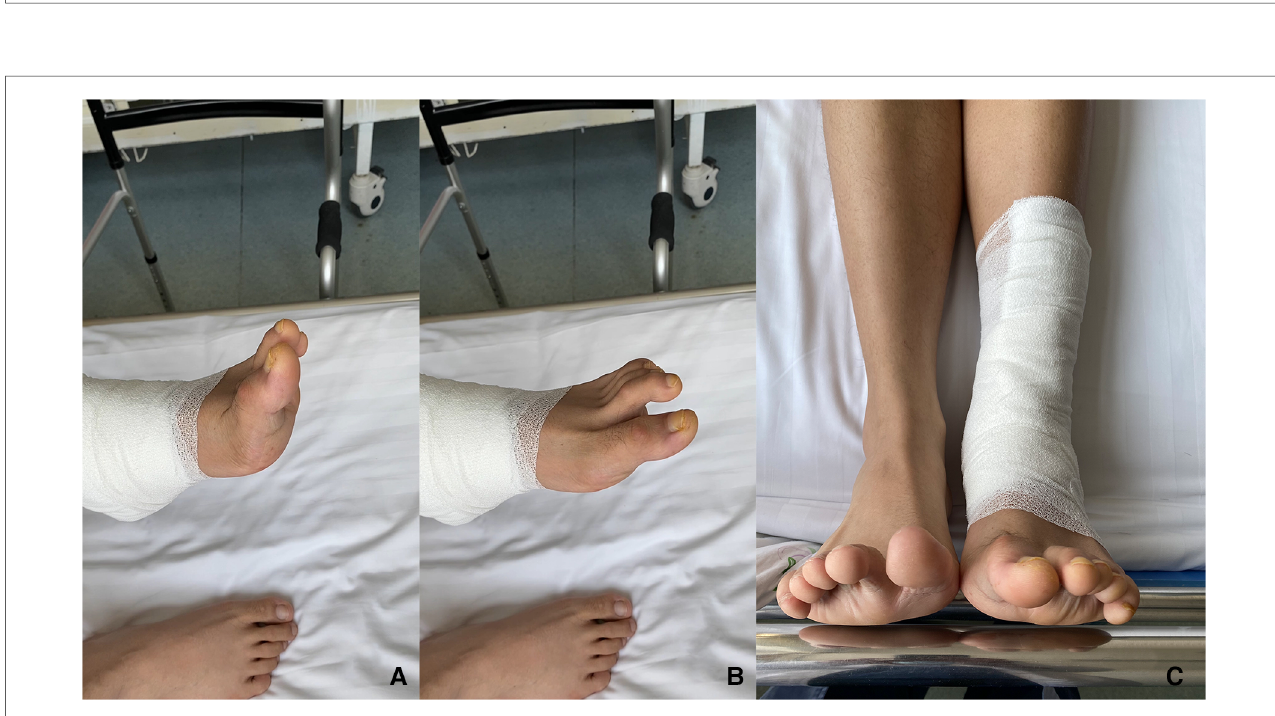
FIGURE 5 Incisions of the exploration operation and FHL tenolysis. ( A ) The glide of the FHL tendon was observed within the malleolar canal through posteromedial incision. ( B ) The FHL muscle belly was attached to the fi bula in the deep posterior compartment.